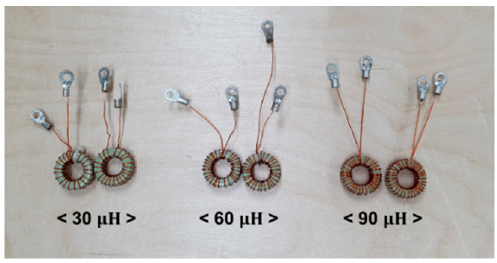
Figure 20. Toroidal inductors manufactured for use as series inductors. Table 11. Measured resistance and calculated resistance value of the manufactured inductor.